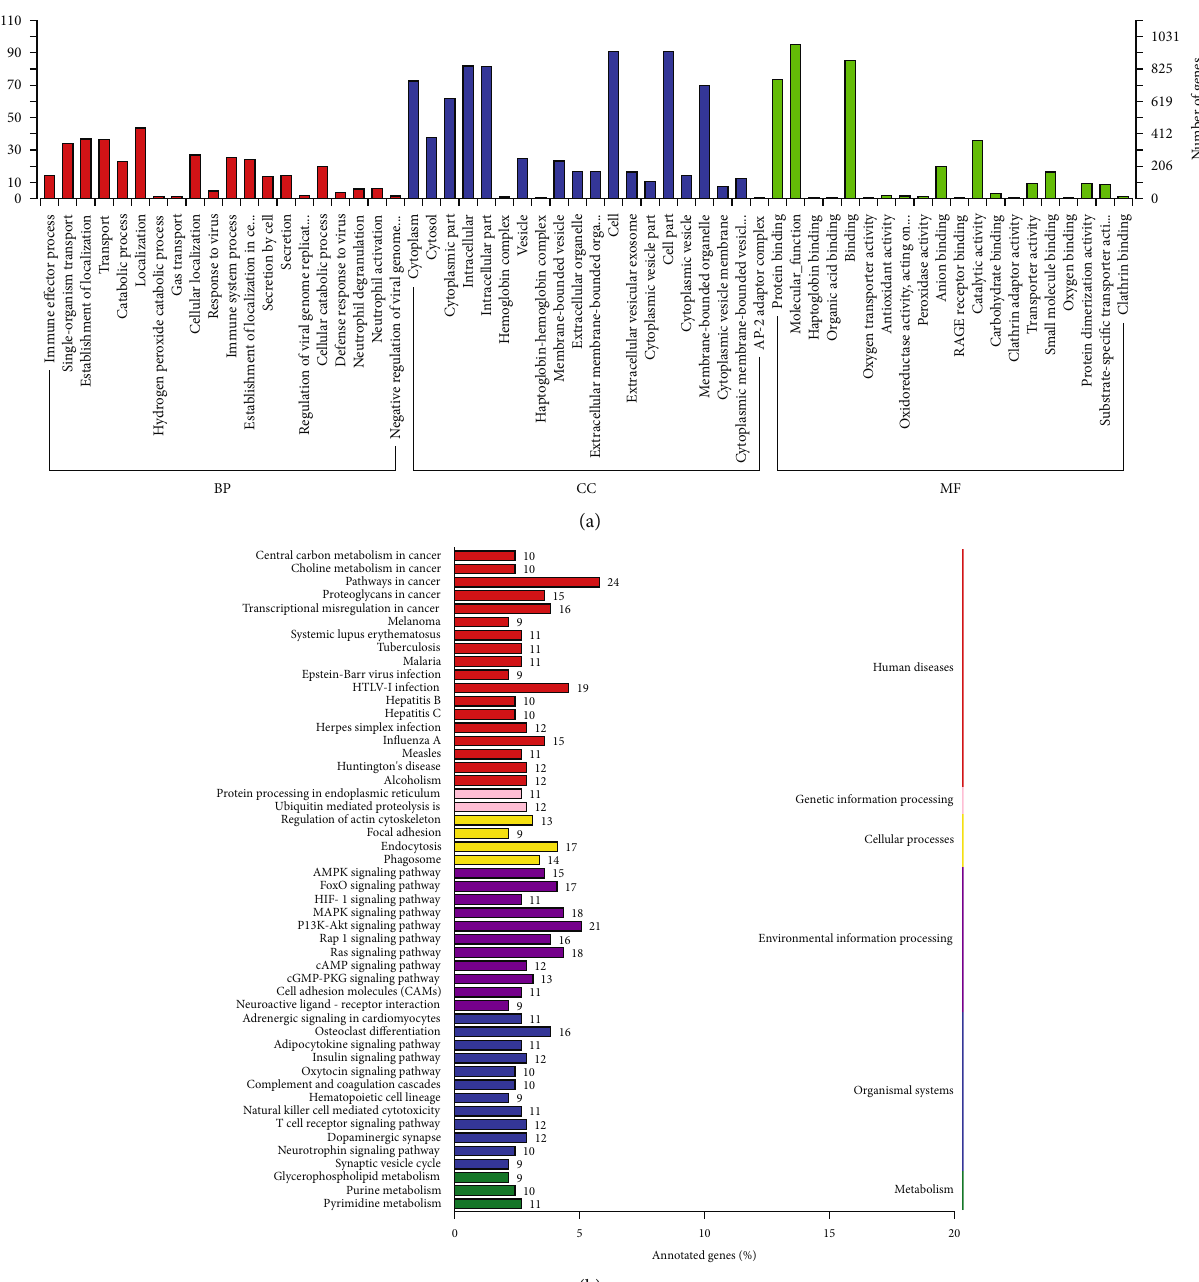
Figure 2: The potential biological functions of di ff erentially expressed mRNAs between DCC and LC. (a) The top twenty Gene Ontology (GO) terms belonging to the categories biological process (BP), cellular component (CC), and molecular function (MF) of DE-mRNAs. (b) Kyoto Encyclopedia of Genes and Genomes (KEGG) pathway